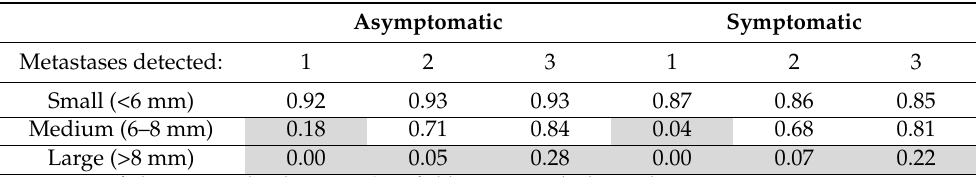
Proportions of oligo+ per risk sub-group. Grey fields represent the low-risk group. Table A7. Proportion of oligo+ within patients with detected oligo-metastases in the Symptomatic Detection Lower scenario.